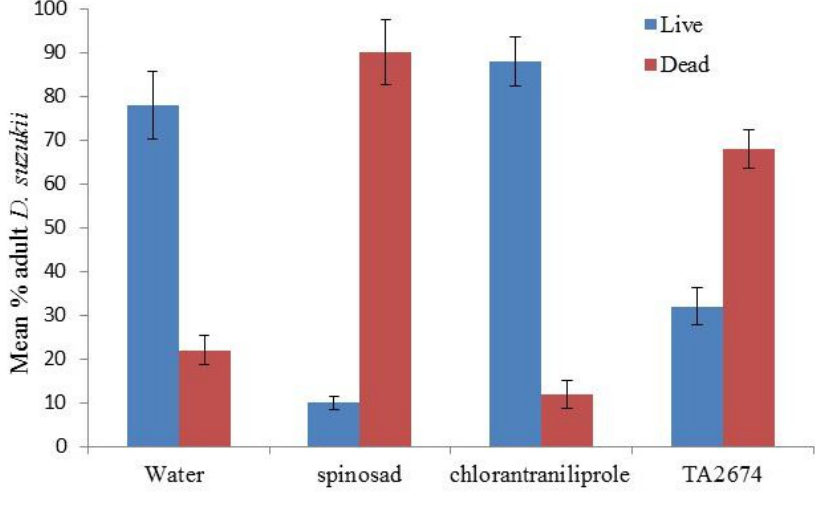
Figure 6. Impact of direct application of chemical control products against adult Drosophila suzukii . Mortality assessed after 48 hours (50 flies per